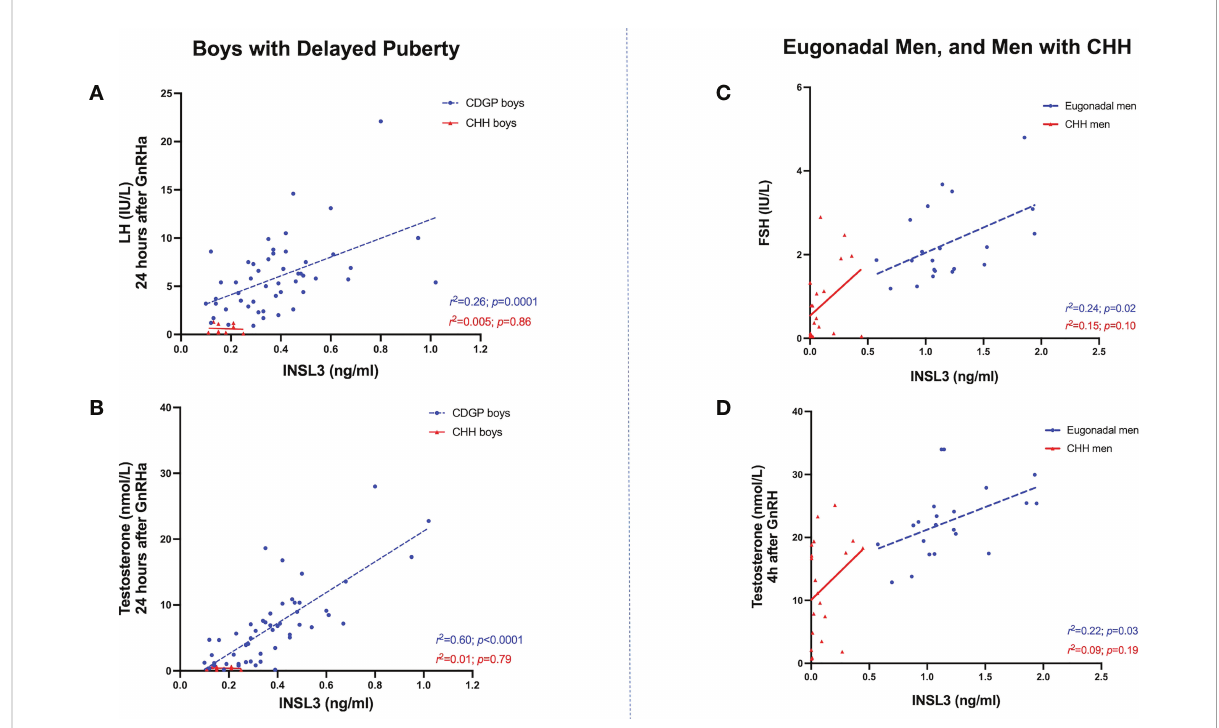
FIGURE 3 (A) Relationship between INSL3 (ng/ml) levels over stimulated LH (IU/L) at 24 hours after GnRHa in boys with CDGP (blue circles) and boys with CHH (red triangles). Simple linear regression r 2 = 0.26; p =0.0001 in CDGP (blue dotted line); r 2 = 0.005; p =0.86 in CHH (red solid line). (B) Relationship between INSL3 (ng/ml) levels over stimulated testosterone (nmol/L) at 24 hours after GnRHa in boys with CDGP (blue circles) and boys with CHH (red triangles). Simple linear regression r 2 = 0.60; p <0.0001 in CDGP (blue dotted line); r 2 = 0.01; p =0.79 in CHH (red solid line). (C) Relationship between INSL3 (ng/ml) levels over basal FSH (IU/L) in eugonadal men (blue circles) and men with CHH (red triangles). Simple linear regression r 2 = 0.24; p =0.02 in eugonadal men (blue dotted line); r 2 = 0.15; p =0.10 in CHH (red solid line). (D) Relationship between INSL3 (ng/ml) levels over stimulated testosterone (nmol/L) at 4 hours after GnRH in eugonadal men (blue circles) and men with CHH (red triangles). Simple linear regression r 2 = 0.22; p =0.03 in eugonadal men (blue dotted line); r 2 = 0.09; p =0.19 in CHH (red solid